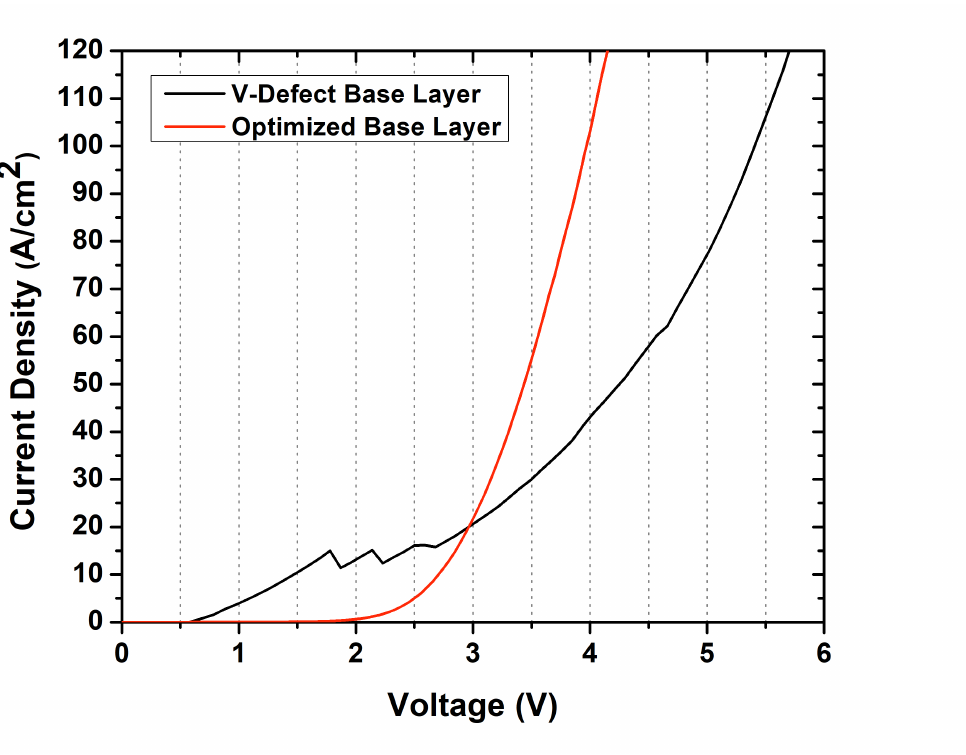
Figure 3. Current density-voltage behavior for selected 80 × 80 µ m 2 devices indicating improvement with base layer optimization.